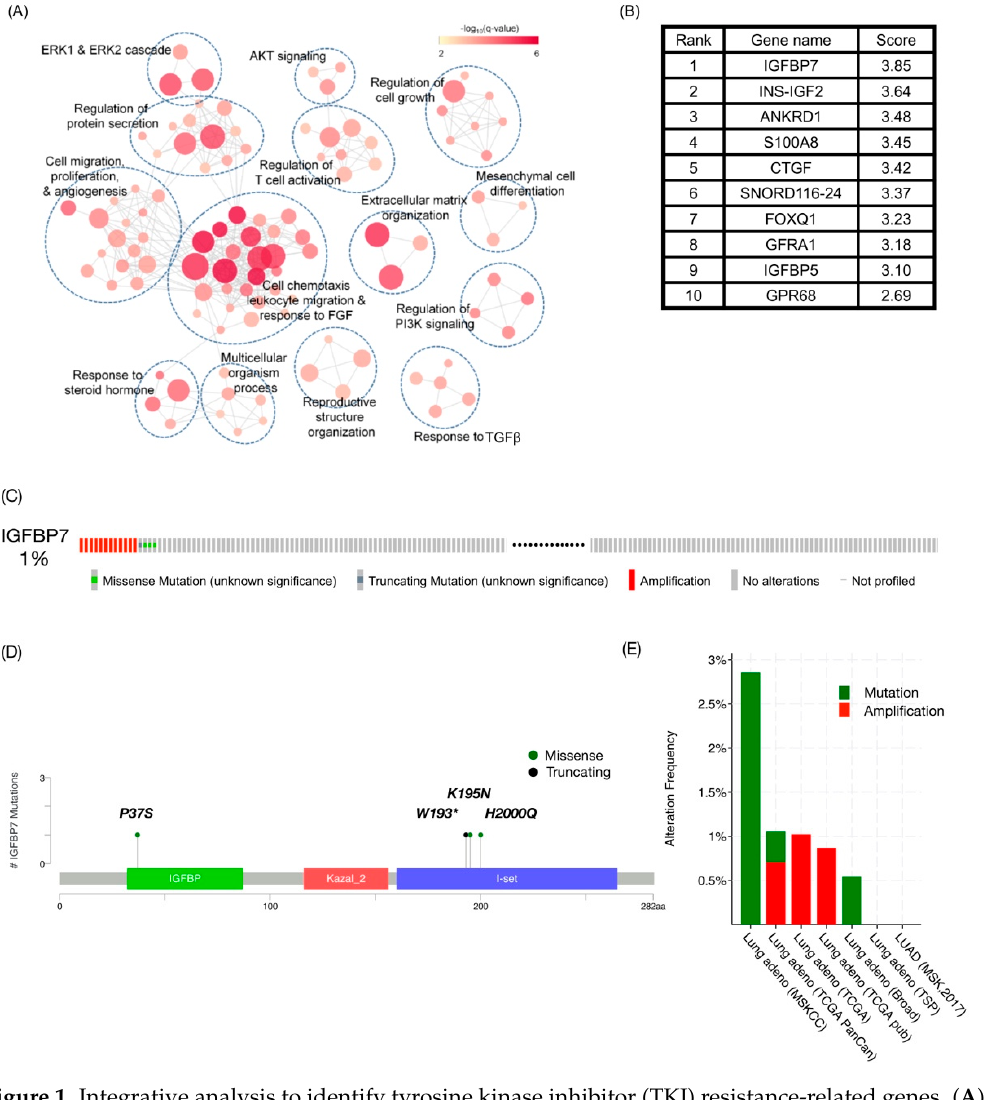
Figure 1. Integrative analysis to identify tyrosine kinase inhibitor (TKI) resistance-related genes. ( A ) Enrichment map of the top 100 TKI resistance-related genes. ( B ) Top 10 TKI resistance-related genes. The nodes represent Gene Ontology (GO) terms, and node colors and size indicate the enrichment significance and number of GO-associated genes. The edges indicate the large amount of overlap between GO-associated genes. ( C ) The oncoprint revealed that 1% (16 altered/1530 profiled) of Lung adenocarcinoma (LUAD) patients had alterations in insulin-like growth factor binding protein 7 (IGFBP7) in the lung adenocarcinoma cohort from cBioPortal of Cancer Genomics. ( D ) Three missense mutations and one truncating mutation in the IGFBP7 locus ( E ) Alteration frequency in different datasets. MSK: Memorial Sloan Kettering Cancer Center; TSP: The Tumor Sequencing Project; TCGA: The Cancer Genome Atlas; MSKCC: Memorial Sloan Kettering Cancer Center; ERK: extracellular-signal-regulated kinase; AKT: protein-kinase B; PI3K: phosphoinositide